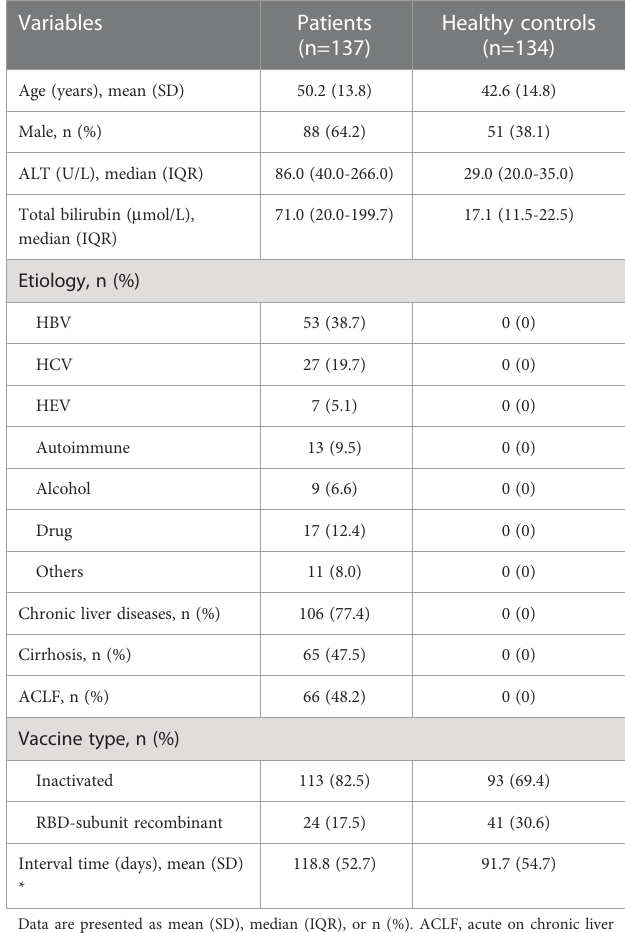
TABLE 1 Characteristics of the